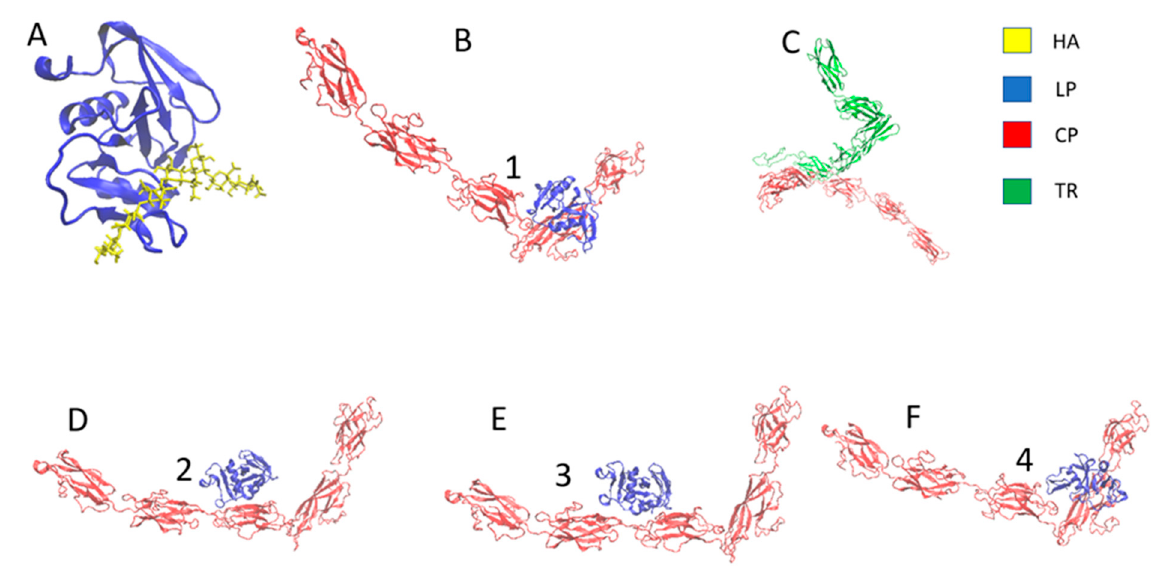
Figure 2. Docked structure ( A ) HA–LP complex, ( B ) LP–CP complex, and ( C ) CP–TR complex. ( B , D – F ) Top 4 energy-minimized structures of the LP–CP complex (proteins are represented in new cartoon representation and hyaluronan is represented in bonded representation and 1, 2, 3 and 4 denotes first four energy minimized structure of LP-CP complex).